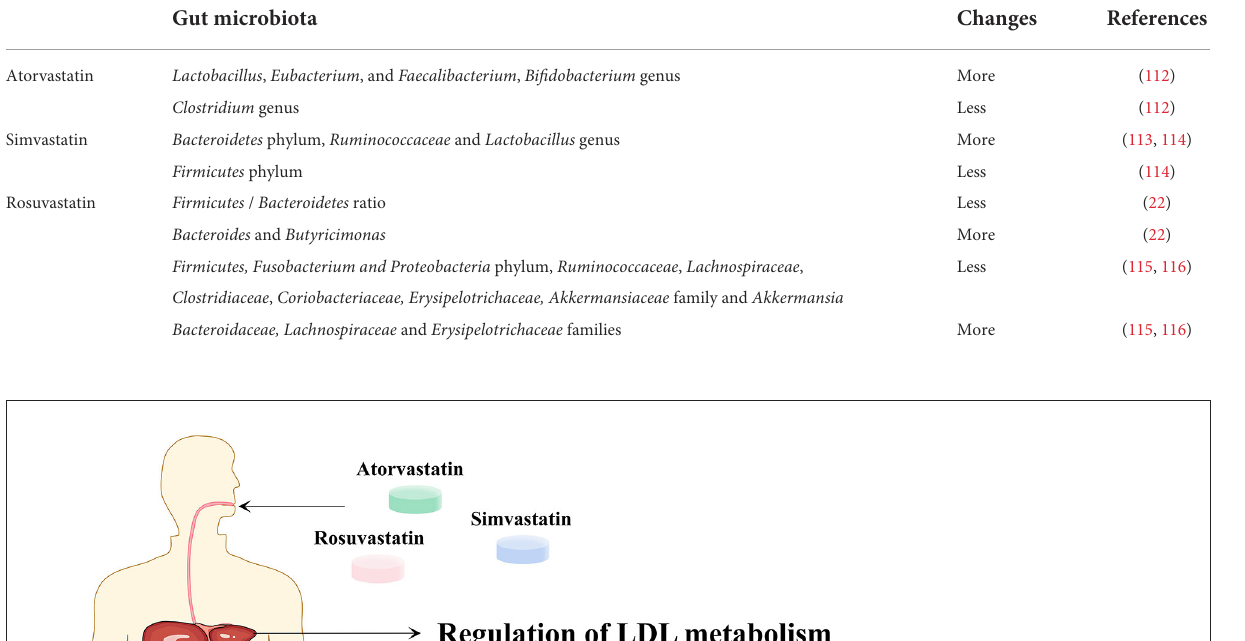
TABLE 2 The effect of some statins on the gut microbiota.